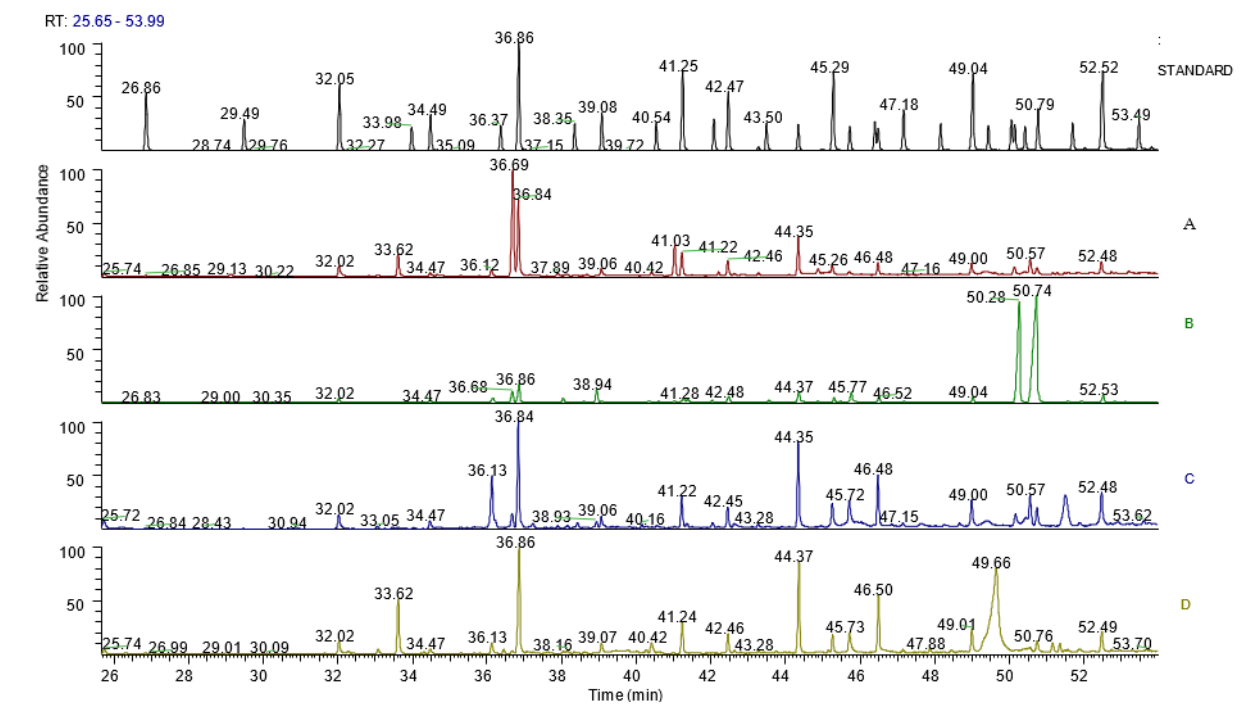
Figure 5. Shows the GC ‐ MS chromatogram of the fatty acids of aqueous acetone extract of H.pandurifolium, H.foetidum H.petiolare, and H.cymocum with regularly labelled signals detected by the GC ‐ MS detector. LEGEND: ( A )—FAMEs chromatogram of H. pandurifolium; ( B )—FAMEs chromatogram of H. foetidum; ( C )—FAMEs chromatogram of H. petiolare; ( D )—FAMEs chromatogram of H. cymocum .